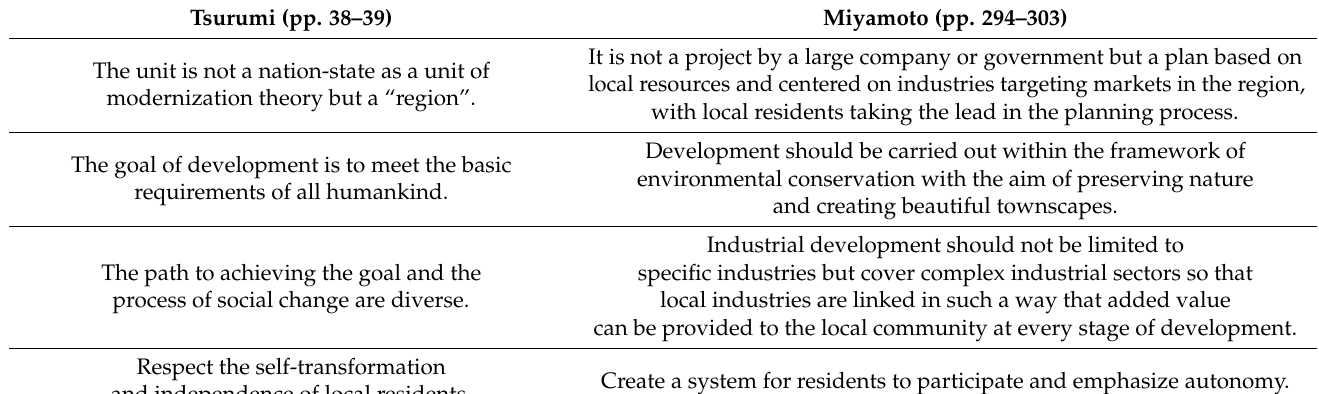
Table 1. Differences between perspectives of Tsurumi [14] and Miyamoto [18] on endogenous